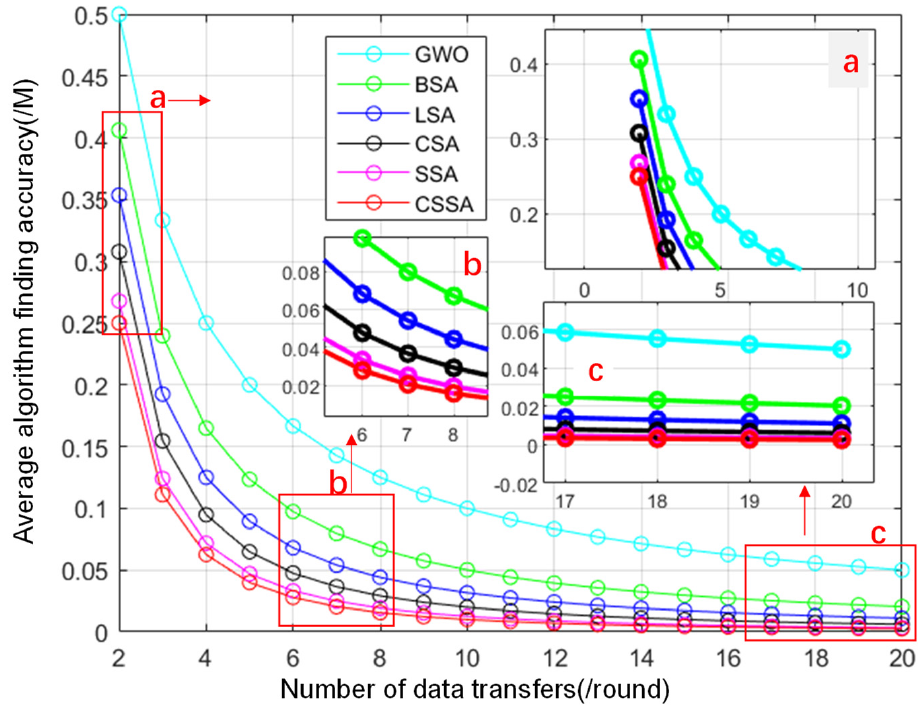
Figure 4. Comparison of complexities of different algorithms. ( a ) Algorithm complexity calculation starting point. ( b ) Curve flattening trend turning point. ( c ) Algorithm stabilization node.